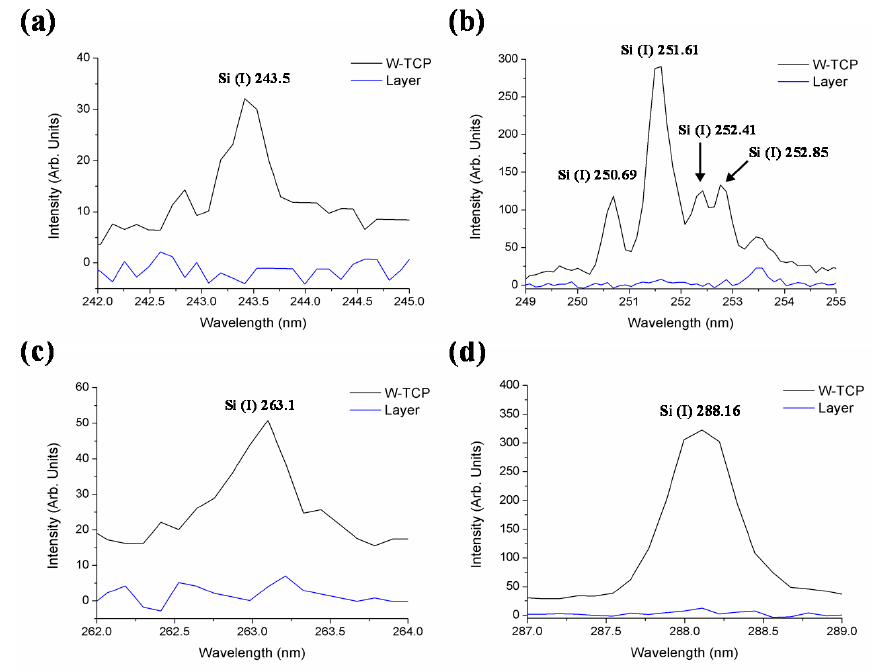
Figure 2. LIBS spectral signals of Si (I) in both the W-TCP eutectic glass and the HA layer at 243.5 nm ( a ), 250.69, 251.61, 252.41, 252.85 nm ( b ), 263.1 ( c ) and 288.16 ( d ).